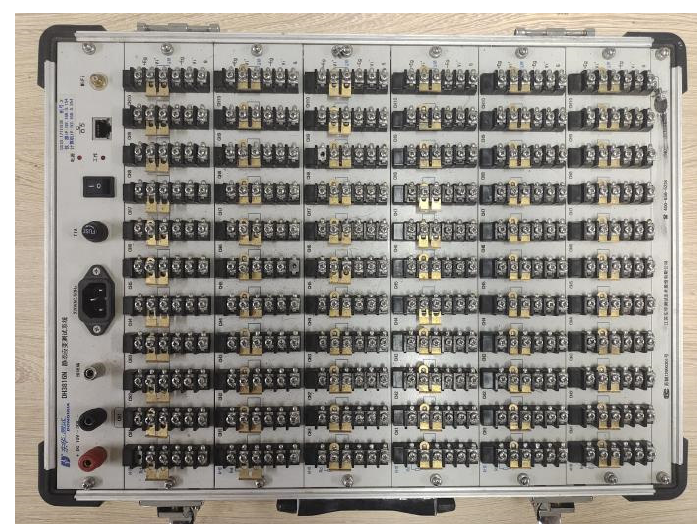
Figure 9. DH3816N static strain collector.